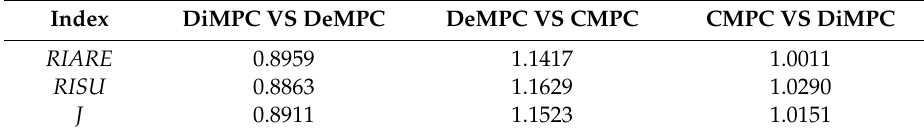
Table 5. Performance indexes for RIARE and RISU.